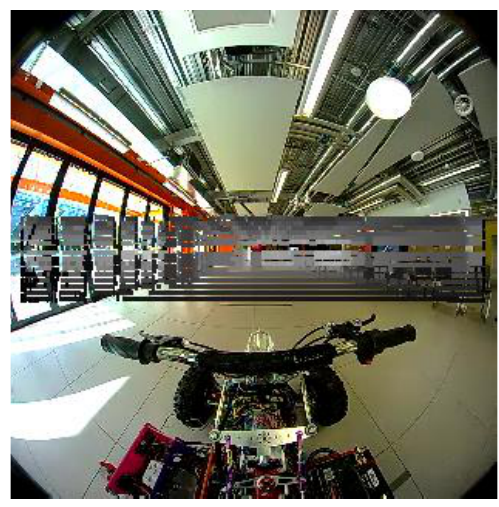
Figure 7. Projection of LiDAR data on to the spherical video frame.